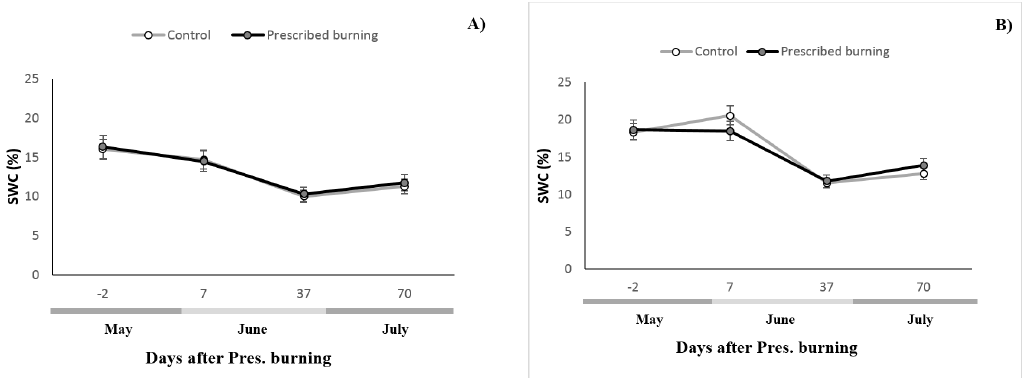
Figure 1. Temporal evolution of the soil temperature (°C) and water soil content (SWC, %) (mean ± Standard Error) in the control and burned zones. ( A ) corresponds to the pure stand, and ( B ) to the mixed stand.